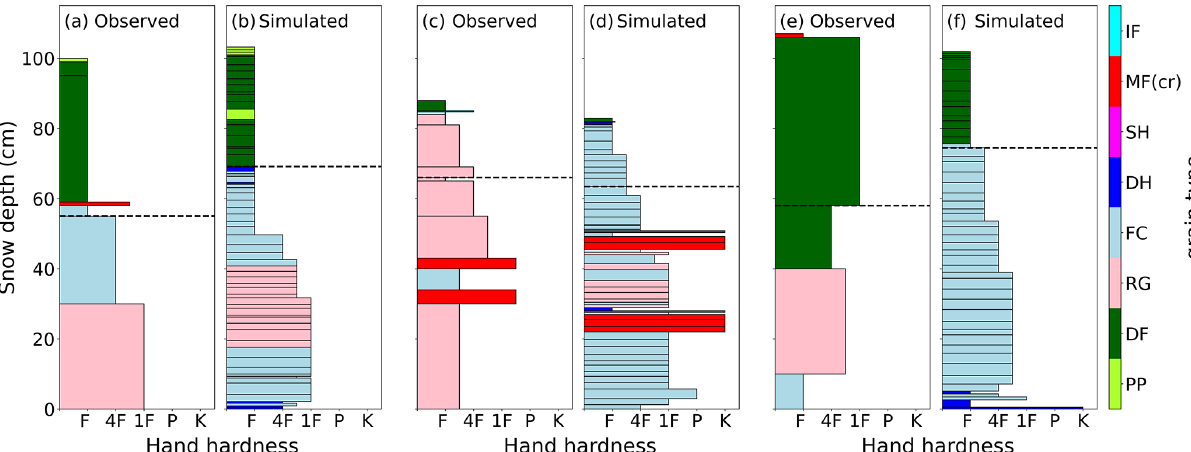
Figure 3. Exemplary profile pairs from the DAV data set with ( a , c , e ) manually observed snow profiles and ( b , d , f ) corresponding simulated snow stratigraphy from SNOWPACK. Hand hardness and grain type (colors) were coded after Fierz et al. (2009), where F corresponds to fist, 4F to four fingers, 1F to one finger, P to pencil and K to knife. Grain types are precipitation particles (PP), decomposing and fragmented precipitation particles (DF), rounded grains (RG), faceted crystals (FC), depth hoar (DH), surface hoar (SH), melt forms (MF), melt–freeze crusts (MFcr), and ice formations (IF). The dashed horizontal line in the manual profile displays the observed height of the RB failure layer, and the corresponding manually determined layer is indicated by a dashed line in the respective simulated profile. Profile pairs (a,b) and (c,d) passed the similarity check, while profile pair (e,f) was sorted out. Observed rutschblock results were (a) RB score 1, whole block; (b) RB score 5, edge; and (c) RB score 4, whole block. The local nowcasts were given by (a) LN = 3, (b) LN = 1 and (c) LN = 2.